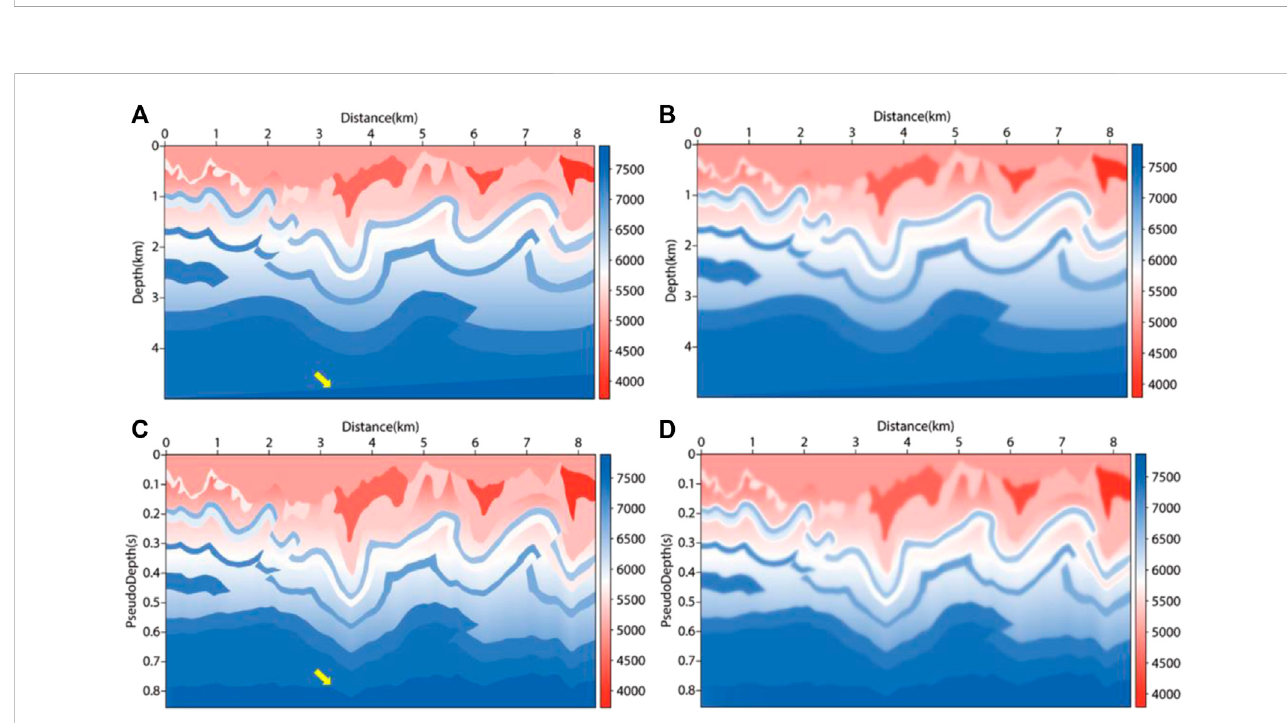
FIGURE 13 Velocity fi eld of complex overthrust. (A) true velocity fi eld indepth domain; (B) migration velocity fi eld indepth domain; (C) true velocity fi eld inpseudo- depth domain; (D) migration velocity fi eld in pseudo-depth